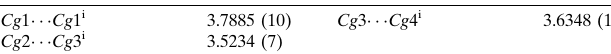
Data collection